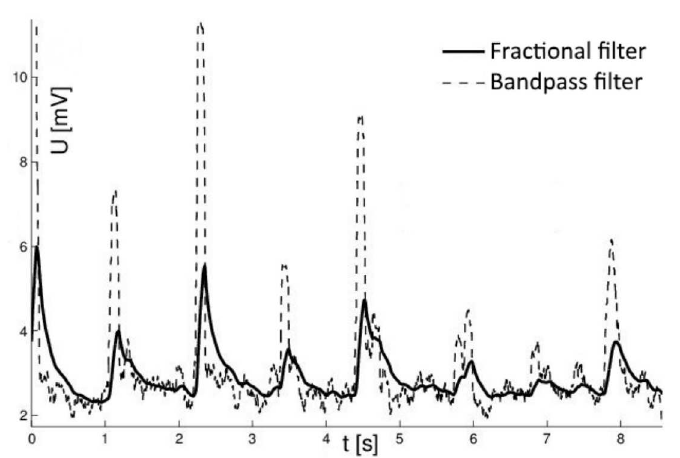
Figure 4. Fractional and band-pass filtering of the analyzed point (sample 2)